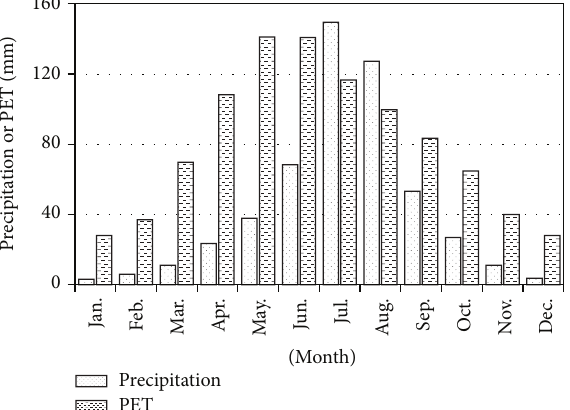
Figure 2: Average monthly areal precipitation and PET in Haihe River basin during